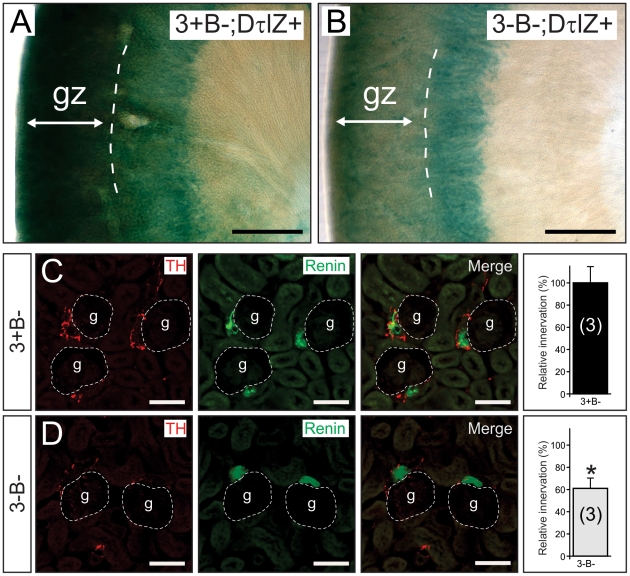
Renal sympathetic innervation abnormalities in the absence of Egr3 and sympathetic neuron death.(A, B) Lacz histochemistry highlighted diffuse renal cortical sympathetic innervation in mice expressing the DτlZ reporter transgene. (B) In the absence of Egr3 and sympathetic neuron death (3-B−;DτlZ) there was a marked decrease in lacZ staining in the glomerular zone (gz) of the renal cortex compared to (A) control (3+B−; DτlZ) mice. (scale bar = 500 µm) (C, D) The decreased sympathetic innervation in the gz was correlated with a 40% reduction of (C, D) sympathetic innervation (TH immunofluorescence, left) to the renin expressing juxtaglomerular (jg) apparatus (renin immunofluorescence, middle) within the gz. (scale bar = 50 µm) (results of TH immunofluorescence quantification representing the mean ± standard error in the area juxtaposed to the jg apparatus; * = p<0.01, Student's t test compared to 3+B−; DτlZ+ control mice; number of 4–8 week old animals analyzed indicated in parentheses).